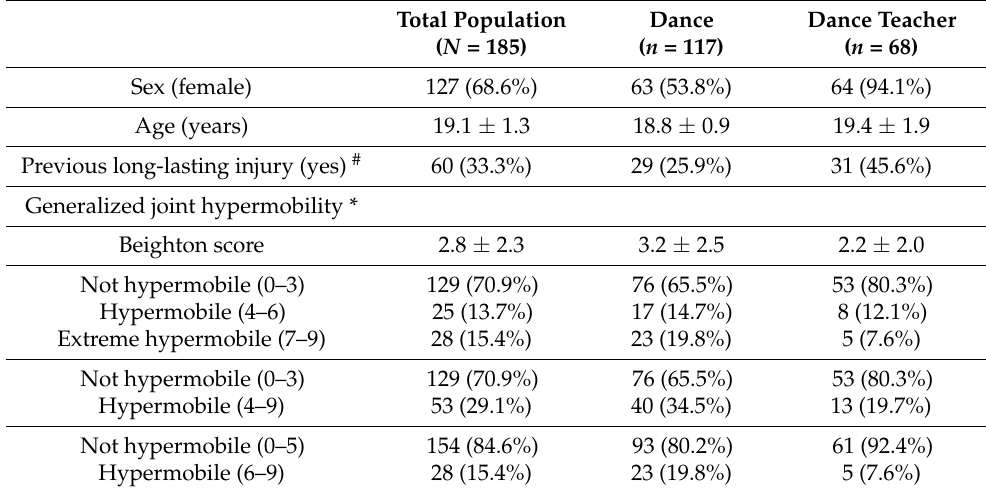
Table 1. Baseline characteristics of the total study population and separated for the Bachelor Dance program and the Bachelor Dance teacher